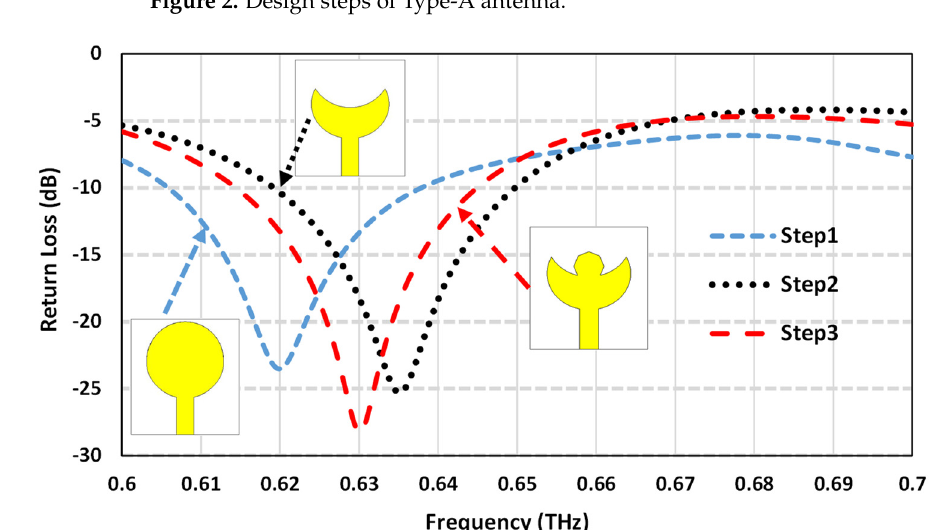
Figure 3. The return loss of design evaluation of Type-A antenna.